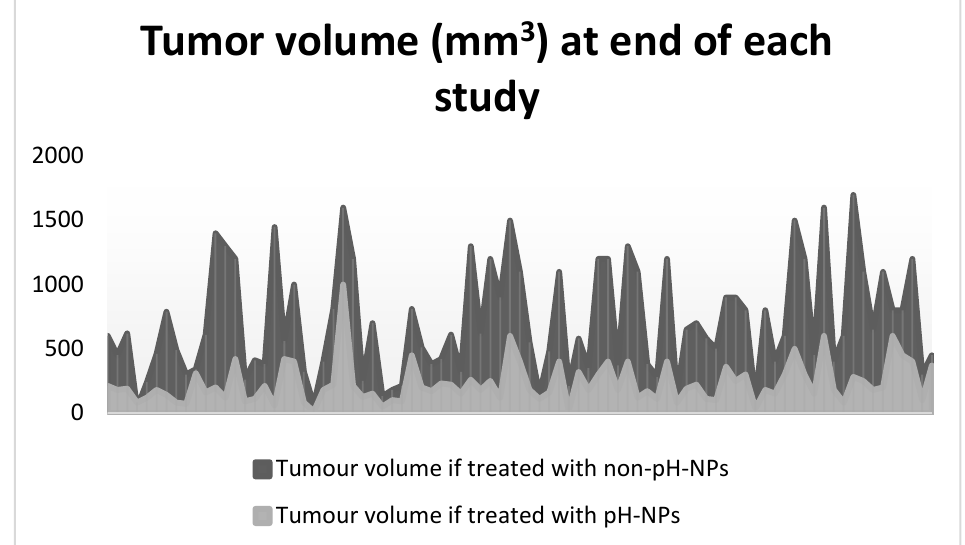
Figure 4. Volume of tumor (mm 3 ) at the end of experiment for each of the included studies. Dark gray area shows the tumor volume for specimens treated with non-pH-NPs. Light gray area shows the tumor volume for specimens treated with pH-NPs.